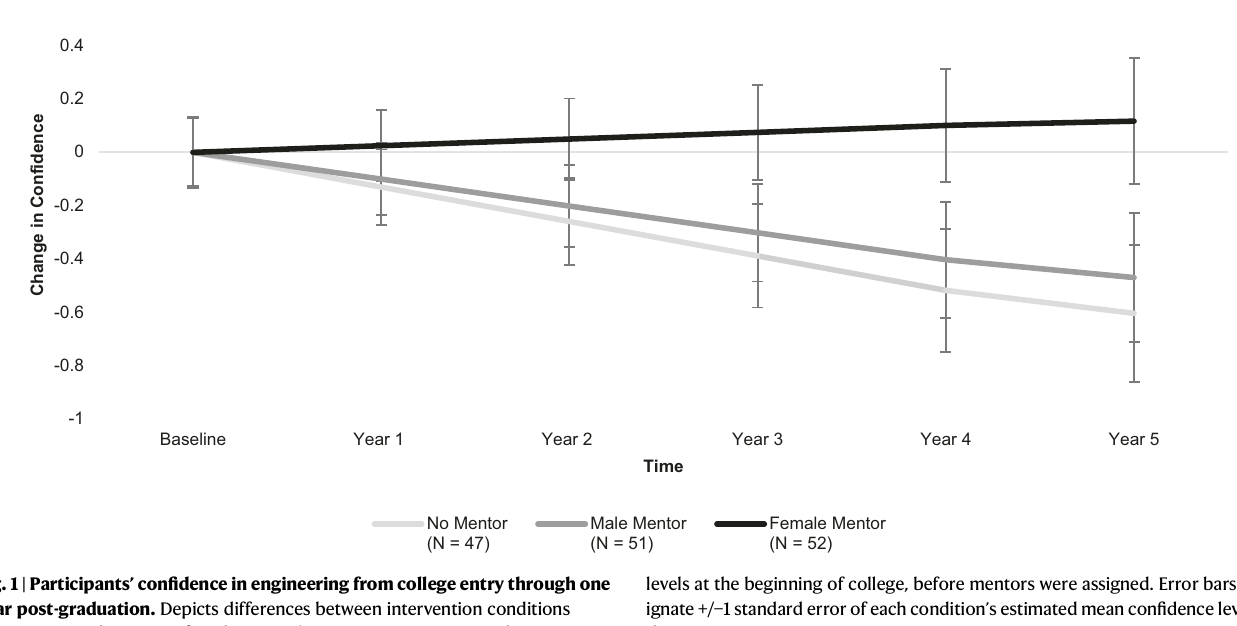
levels at the beginning of college, before mentors were assigned. Error bars des- ignate+/ − 1standarderrorofeachcondition ’ sestimatedmeancon fi dencelevelsat that time-point. N =150